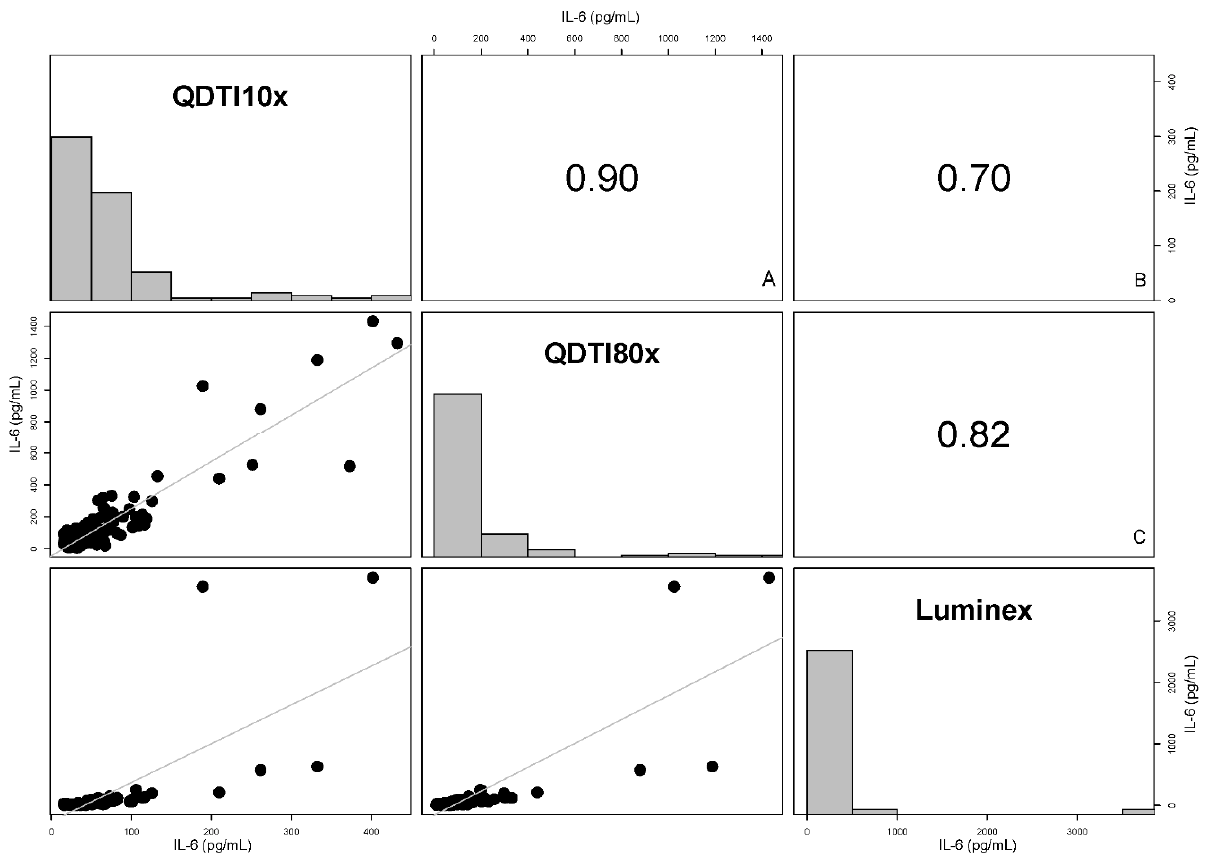
Figure 3. Scatter plot matrix displaying associations between IL-6 concentrations between QDTI instrument and Luminex assay. High correlations were observed between the IL-6 concentrations ( A ) between QDTI10x and QDTI80x (r = 0.90, p -value < 0.001) and ( B ) between the Luminex and QDTI10x (r = 0.70, p -value < 0.001) and ( C ) between the Luminex and QDTI80x (r = 0.82, p -value < 0.001). Table 4. IL-6 mean concentrations by Luminex, QDTI10x, and QDTI80x for patients admitted to the